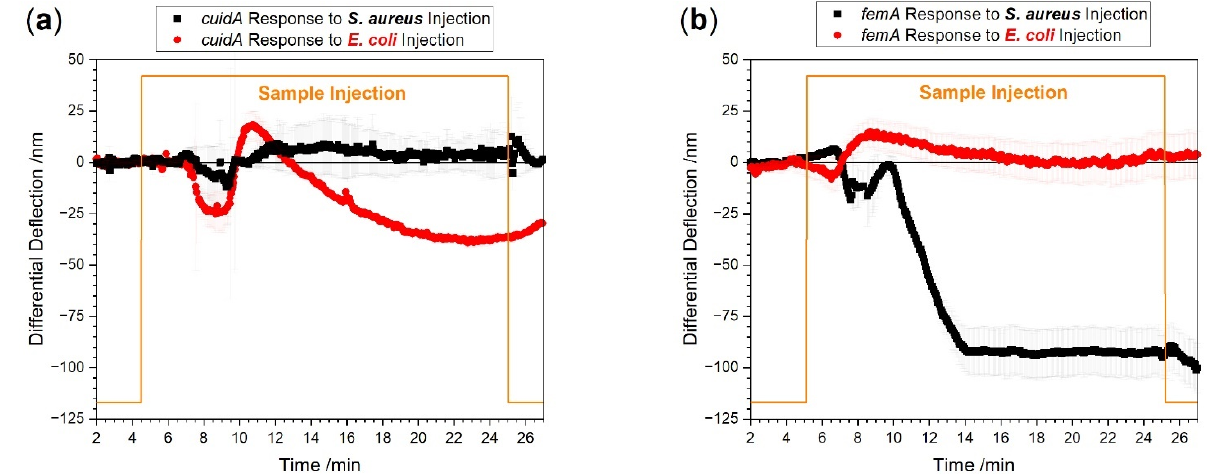
Figure 6. Measurements with species-specific probes directly from EDTA whole blood. Total RNA concentration was adjusted to 100 pg/ µ L sample. The red curve shows E. coli specific responses. S. aureus specific responses are shown in black. In panel ( a ), total RNA from an E. coli positive patient was used showing a uidA specific (red) and no S. aureus uidA response (black). In panel ( b ), total RNA from an S. aureus positive patient was tested showing an S. aureus femA specific (black) and no E. coli uidA specific response (red).